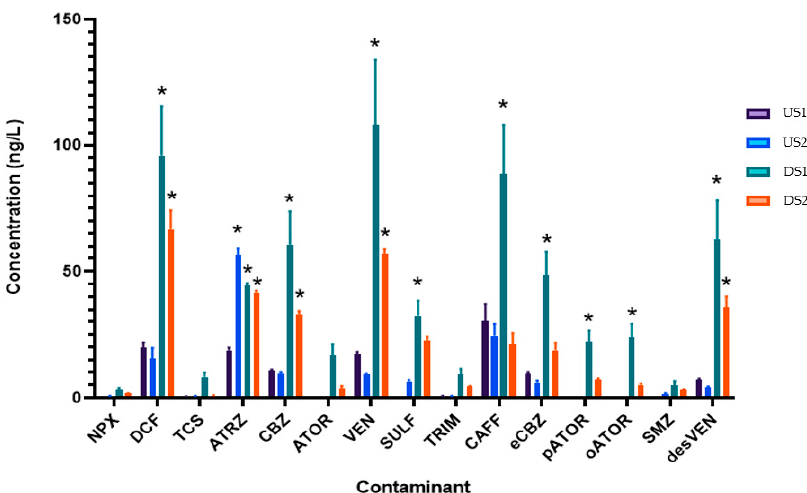
Figure 2. Pharmaceuticals and contaminants measured in the Grand River in summer 2019. Data are presented as mean ± SEM ( n = 3 per site). Concentrations (ng/L) of many pharmaceuticals and personal care products were detectable throughout the watershed but usually increased downstream from the MWWTP. Abbreviations on the x-axis from left to right: naproxen (NPX), diclofenac (DCF), triclosan (TCS), atrazine (ATRZ), carbamazepine (CBZ), atorvastatin (ATOR), venlafaxine (VEN), sulfamethoxazole (SULF), trimethoprim (TRIM), caffeine (CAFF), 11,12-epoxide carbamazepine (eCBZ), p-hydroxy atorvastatin (pATOR), o-hydroxy atorvastatin (oATOR), sulfamethazine (SMZ), desmethyl venlafaxine (desVEN). US1, upstream 1; US2, upstream 2; MWWTP, municipal wastewater treatment plant; DS1, downstream 1; DS2, downstream 2. An asterisk indicates a significant difference in concentration compared to US1 (Dunnett’s multiple comparisons test, p < 0.05).